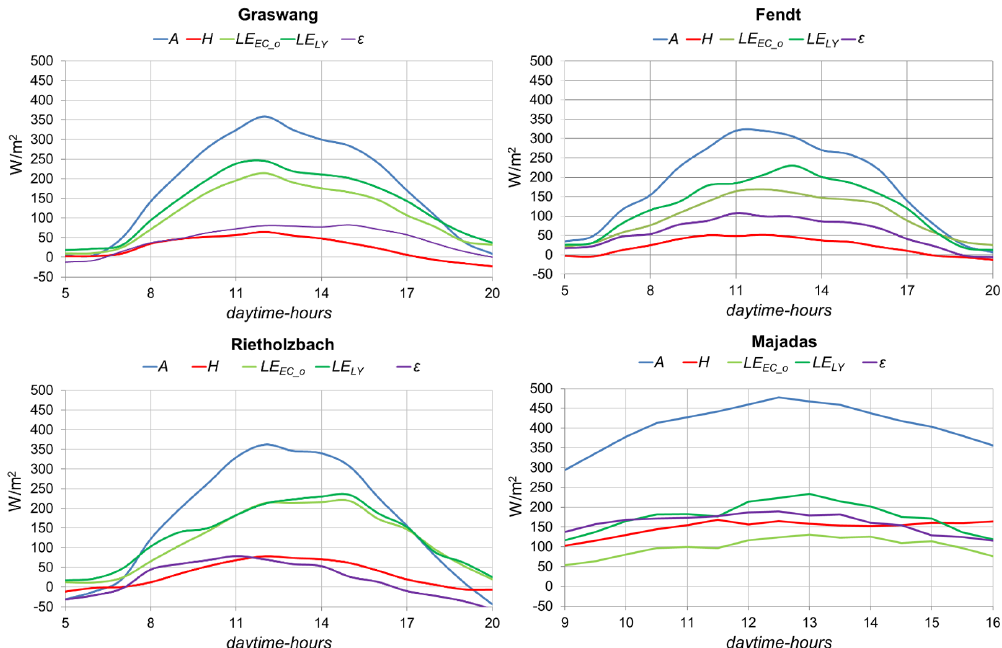
Figure 2. Average daytime course of available energy ( A ), sensible heat flux ( H ), EC-based (LE EC_o ) and lysimeter-based (LE LY ) latent heat flux and the energy gap ( ε ) at the four stations. Note that for Majadas the diurnal cycle represents the dry season (M4).